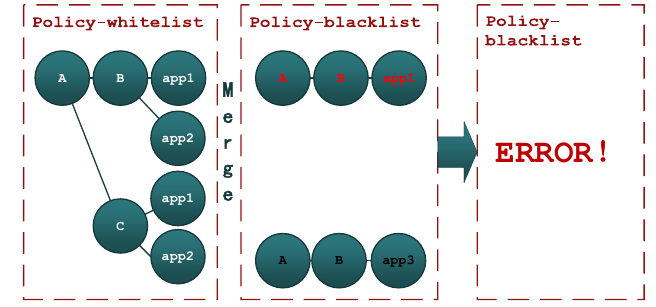
Figure 3. Tree mergers of config in the blacklist.